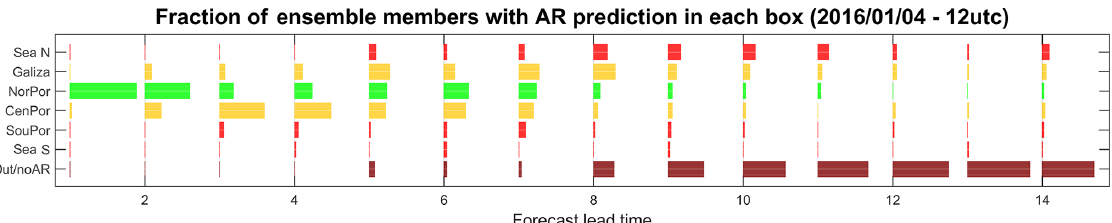
Figure 7. Shown is the percentage of ensemble members forecasting IVT above 450kgm − 1 s − 1 in each of the regional boxes and for each lead time for the case study presented in Fig. 3 (4 January 2016). Green bars represent a spatially accurate forecast (in the box where the maximum IVT was observed). Yellow bars represent a forecast in a box adjacent to where it was actually observed. Red bars represent a forecast in one of the remaining boxes. The bars in the bottom row represent a completely missed forecast, by either (i) no AR forecast or (ii) an AR forecast outside of the six considered boxes in western Iberia.